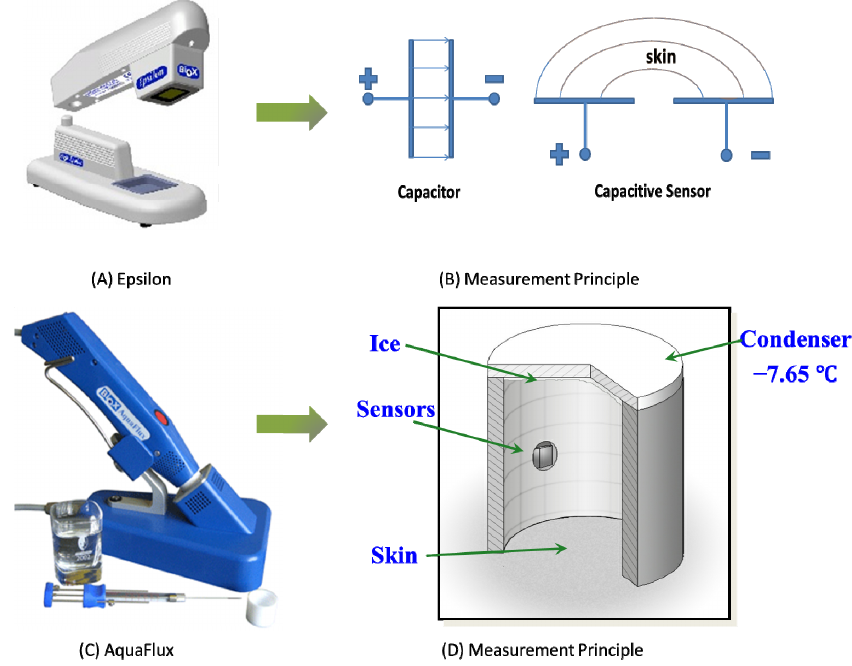
Figure 1. Epsilon permittivity imaging system ( A ) and its measurement principle ( B ); AquaFlux ( C ) and its measurement principle ( D ).